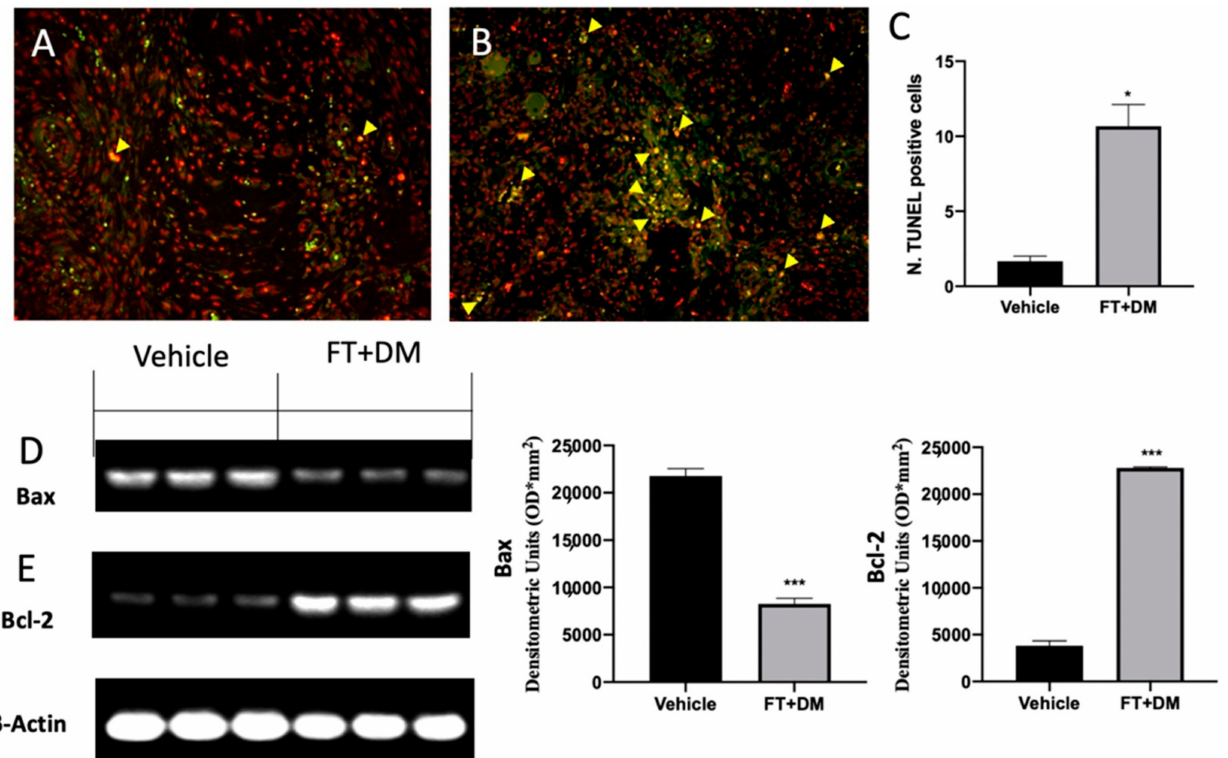
Figure 6. FT+DM administration reduced apoptosis. Histological analysis and TUNEL assay (40 × magnification; 75 µ m scale bar): vehicle ( A ); FT+DM ( B ). Number of TUNEL positive cells ( C ). Western blot analysis of Bax ( D ) and Bcl-2 ( E ). A p -value of less than 0.05 was considered significant: * p < 0.05 vs. vehicle, *** p < 0.001 vs.